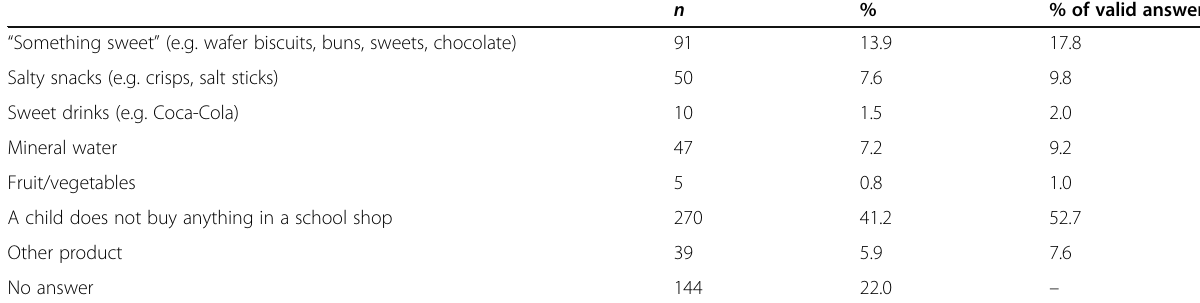
Table 5 The percentage division of children aged 10 – 13 depending on the most often bought article in a school shop